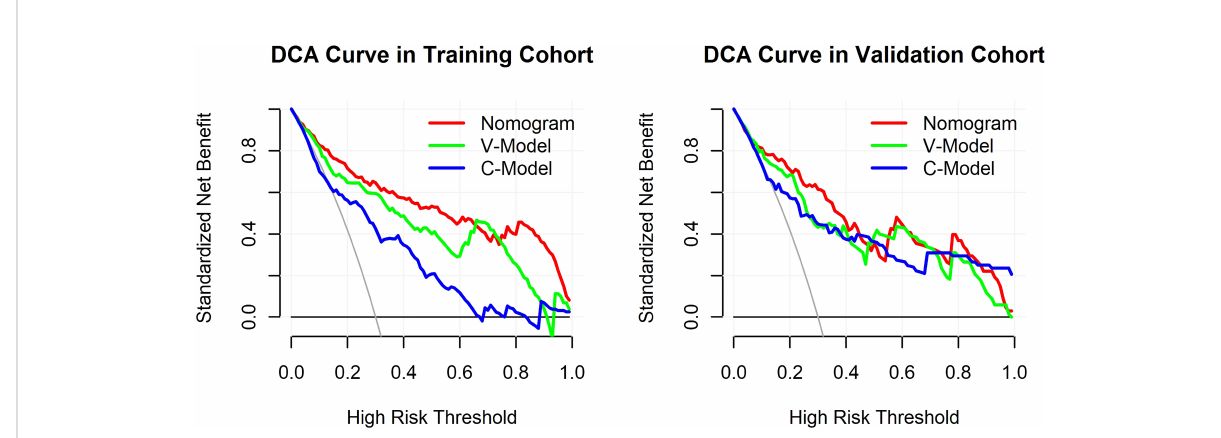
FIGURE 6 Decision curve analysis (DCA) for the constructed models. The y-axis measured the standardized net bene fi t. The horizontal line represented that none of the patients has diabetic retinopathy (DR) and all of them were treatment-free. The other oblique line is drawn on the assumption that all of the type 2 diabetes mellitus (T2DM) patients have DR and received clinical